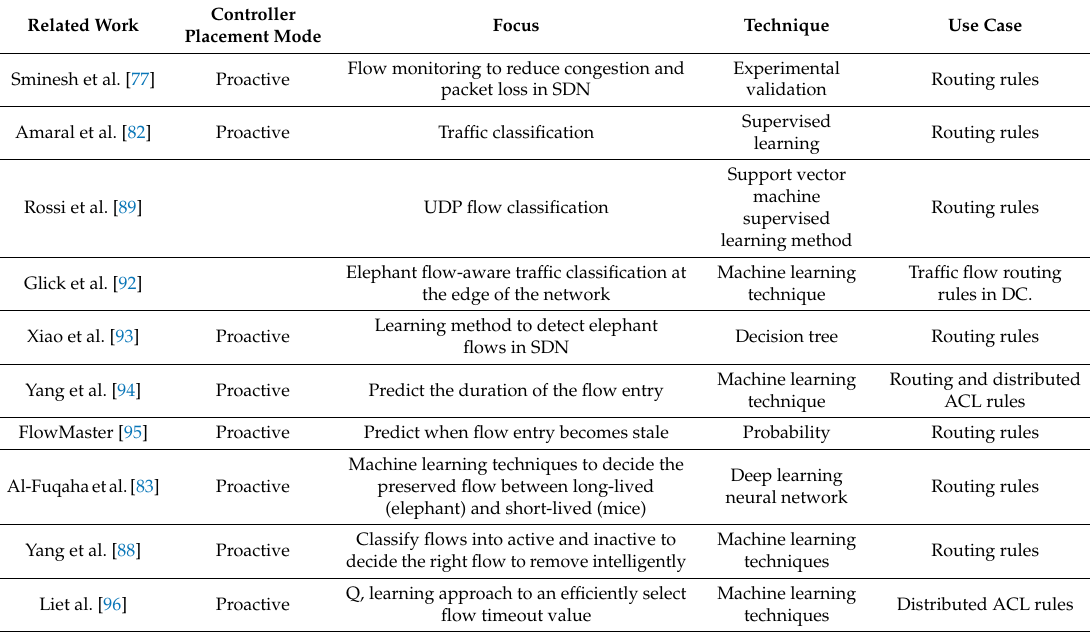
Table 5. Comparison of machine learning related work to improve flowtable